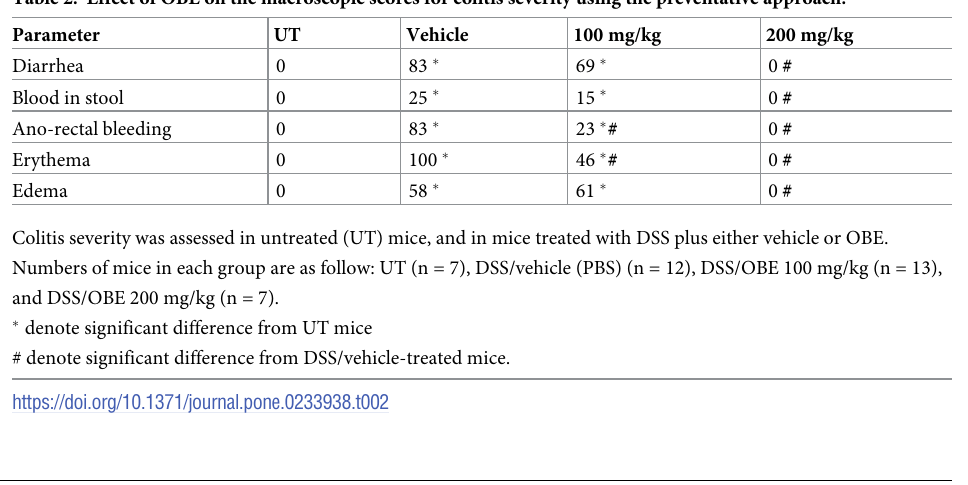
Fig 5. Effect of OBE on colitis severity at the gross level using the preventative approach. The treatment protocol used in the study is illustrated in panel A. Panel B shows % body weight changes in DSS-treated mice receiving vehicle (black triangles), and OBE-treated mice at various doses compared to untreated (UT) mice receiving tap water only (solid gray circles). Colon length (panel C), and thickness (panel D) were determined in mice receiving DSS and either vehicle (solid bars), or various doses of OBE (hatched bars) and in the UT mice (open bars). Histobars represent means ± SEM for the following number of mice in each group: UT (n = 7), DSS/vehicle (PBS) (n = 12), DSS/OBE 100 mg/kg (n = 13), and DSS/OBE 200 mg/kg (n = 7). Asterisks denote significant difference from UT mice with p < 0.05 ( � ), # denotes significant difference from DSS/vehicle-treated mice with p < 0.05.